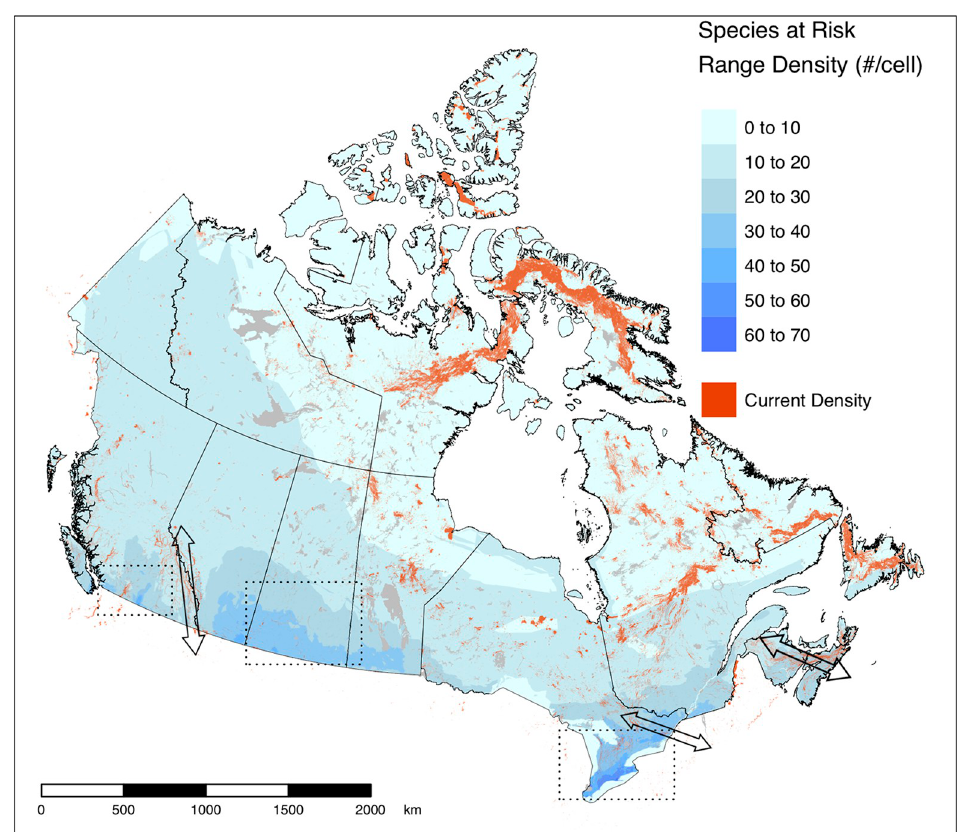
Fig 3. Areas with high current densities over the density of ranges for species at risk in Canada [68]. The 95 th percentile of current densities are displayed in orange. The three dashed boxes indicate the locations of the vignettes (Fig 4A–4C) and the black arrows provide examples of regions with existing connectivity conservation initiatives (Yellowstone to Yukon, Algonquin to Adirondacks, and the Chignetco Isthmus, from left to right). Contains information licensed under the Open Government Licence–Canada.